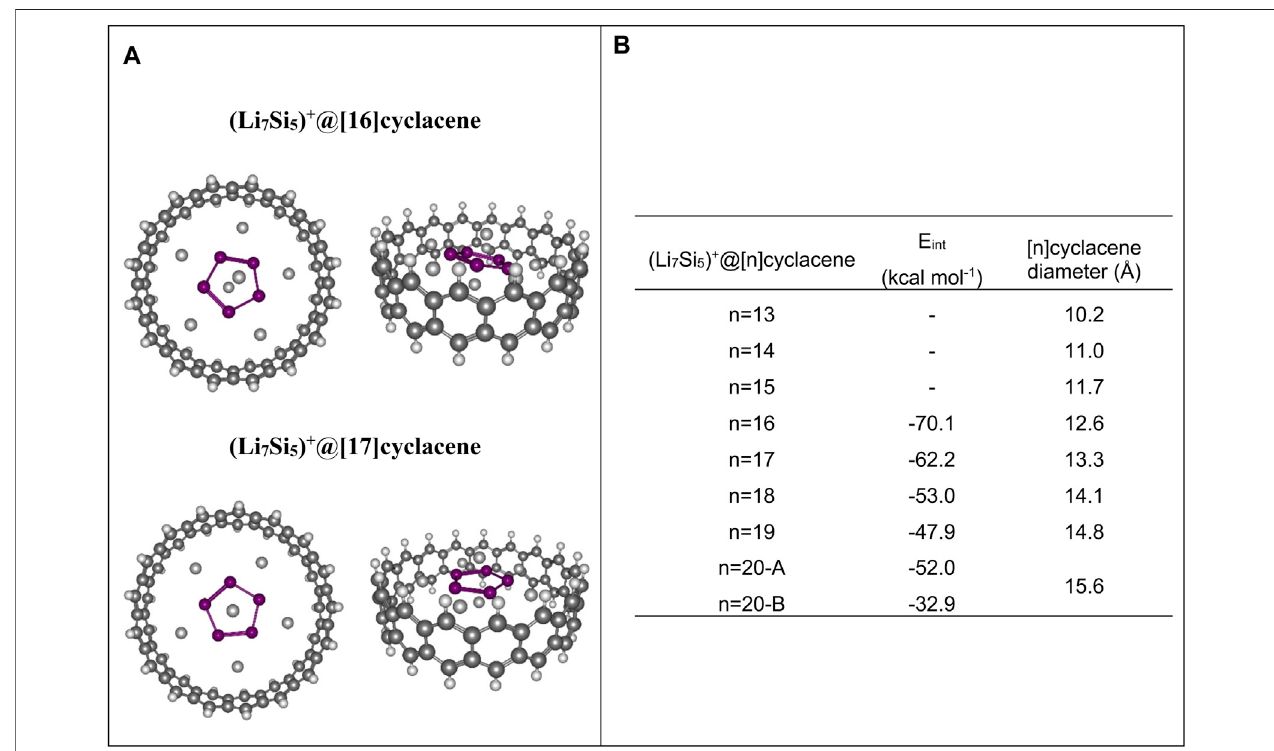
FIGURE 1 | (A) Top-and side-views of optimized structures of Li 7 Si 5+ inside both [16]cyclacene and [17]cyclacene at PBE0/def2-TZVP level. (B) Li 7 Si 5+ and [n] cyclacene interaction energy (E int ), number of hexagonal rings and diameter (in Å) of the [n]cyclacene.